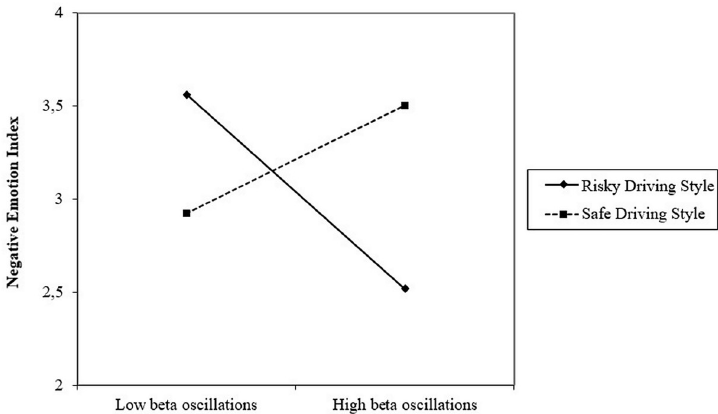
Fig 7. Moderating effect of driving style on the relationship between beta oscillations and the NEI (declarative measure).